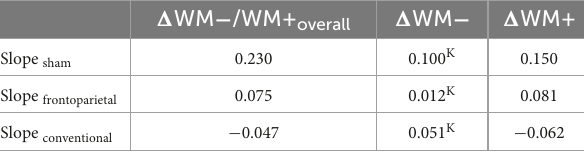
TABLE 2 Correlations between random slopes within distractor inhibition (DIIN) training across stimulation groups with pre-post performance difference in WM − /WM+.